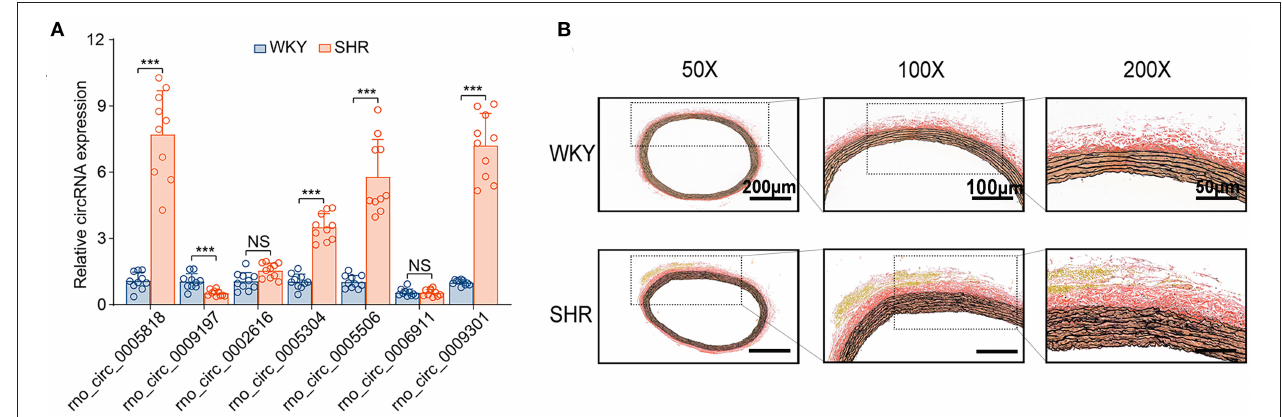
FIGURE 3 | DE circRNAs candidates were validated by RT-PCR between SHR and WKY rat aorta. (A) The seven DE circRNAs were detected by the RT-PCR between SHR and WKY rat aorta. Five significant aortic circRNAs were confirmed in hypertensive rats, including rno_circRNA_0005818, rno_circRNA_0005304, rno_circRNA_0005506, rno_circRNA_0009301, and rno_circRNA_0009197. (B) The EVG staining illustrated that the regulation of circRNAs were associated with thin elastic fiber and thick collagen fiber. Black color represents elastic fiber, red color represents collagen fiber. n = 10 for each group, *** P < 0.001. DE, differentially expressed; circRNAs, circular RNAs; RT-PCR, real-time polymerase chain reaction; WKY, Wistar-Kyoto; SHR spontaneously hypertensive